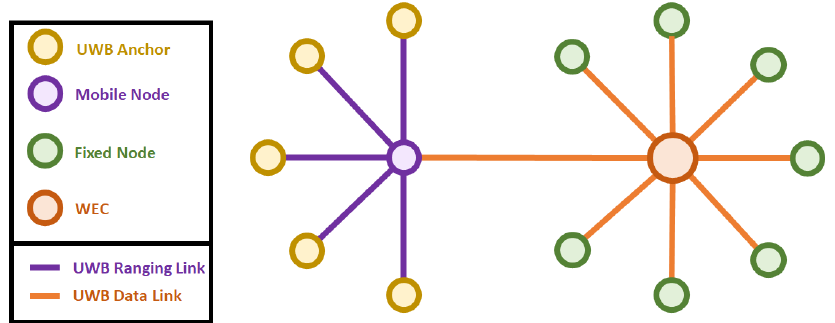
Figure 2. WATEREYE system network